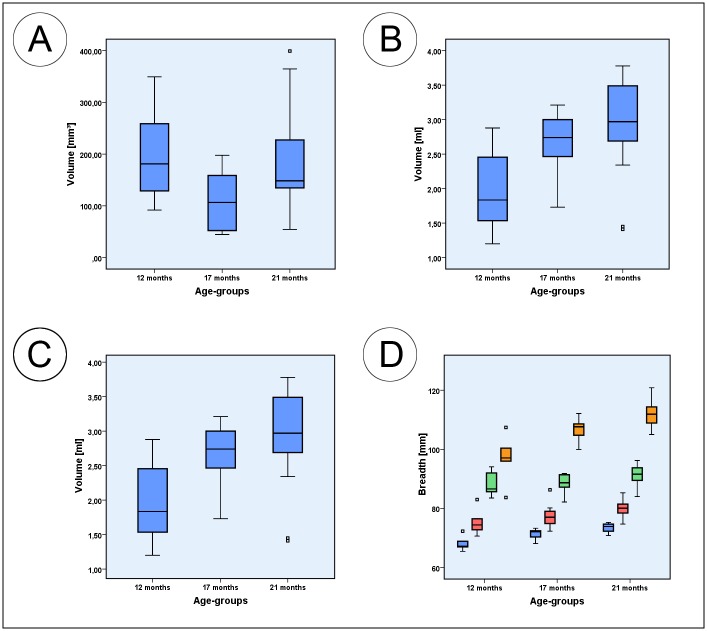
Box plots of measured parameters.(A) Box plots of the coronoid process volume; (B) Box plots of the mandibular condyle volume; (C) Box plots of the anterior mentum height; (D) Box plots of the intercoronoidal breadth (blue); intercondylar breadth (green); intergonial breadth (orange) and breath between sigmoid notches (red). Squares associated with the box plots are individual outliers.